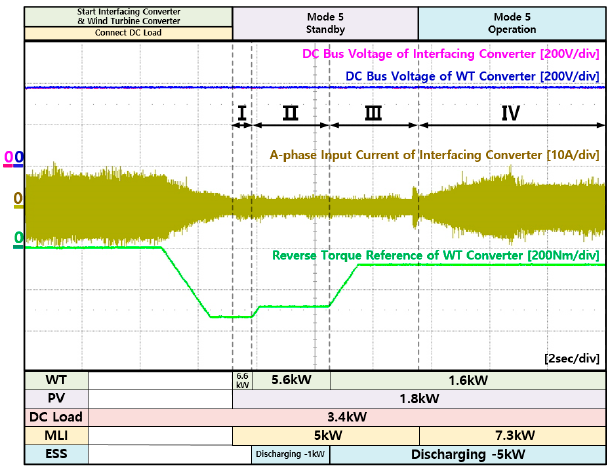
Table 5. Output power of each power conversion devices in mode 5.